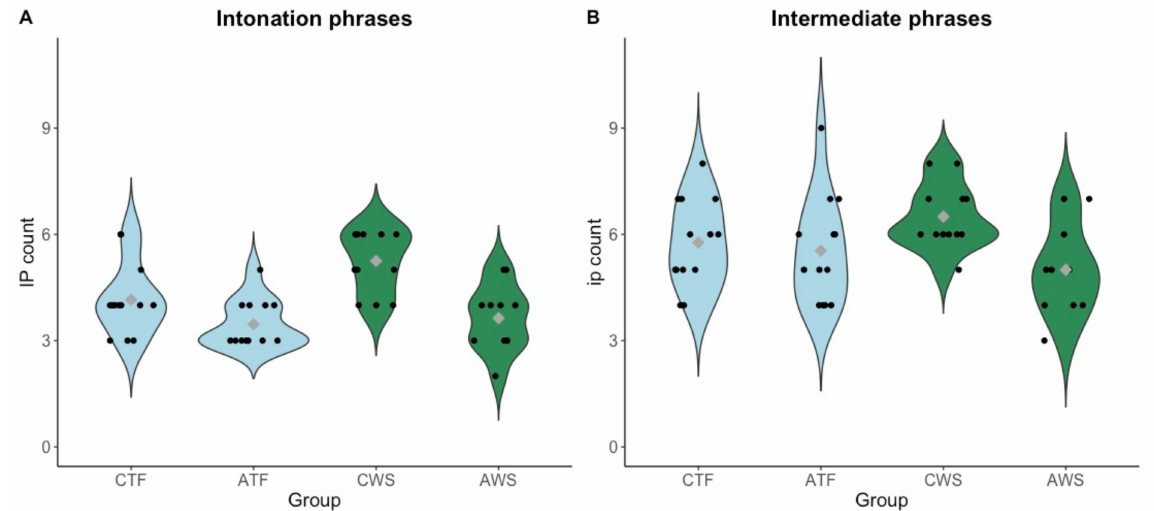
Figure 7. Violin plots for each group, gray diamonds displaying the mean values per group. ( A ): Sum of produced intonation phrases (IPs) per excerpt, each dot represents one participant. ( B ): Sum of produced intermediate phrases (ips) per excerpt, each dot represents one participant. CTF: children with typically fluent speech, ATF: adolescents with typically fluent speech, CWS: children who stutter, AWS: adolescents who